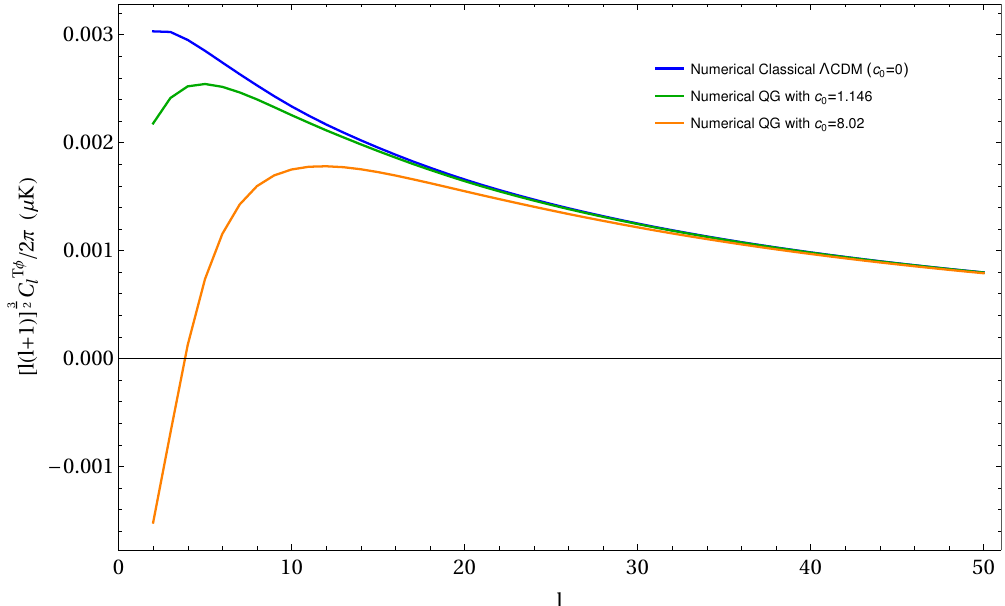
Figure 9. Comparison of the numerical prediction of the classical Λ CDM program vs. numerical predictions of the RG running of Newton’s constant’s effect on the cross-temperature-lensing (T φ ) power spectrum C T φ . The solid curves represent the numerical predictions generated by l ISiTGR, with the bottom (blue), middle (green) and top (orange) representing quantum amplitudes (see Equation (9)) c 0 = 0,1.146,8.02, respectively, showing again just slightly higher trends at large angular scales ( l < 20) as compared to the classical no running numerical Λ CDM curve. No data with reasonable errors are found so far for C T φ . l